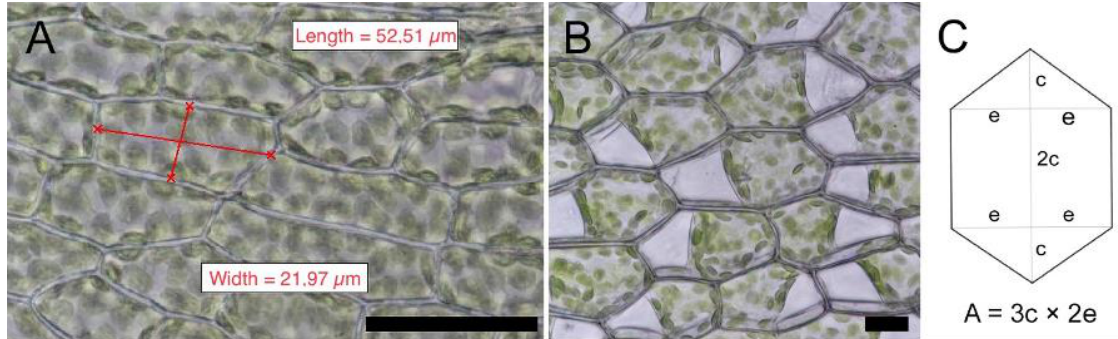
Figure 4. ( A ) measurements of cell length and widths in rectangular cells using the “extended focus” function (Nikon NIS - ElementsBR) of the microscope; bar: 50 µM; and ( B ) hexagonal cell type of P. affine , plasmolyzed in 0.8 M mannitol for 20 min; the protoplasts are detached from the cell wall; bar: 25 µM. ( C ) schematic and formula for area calculation of hexagonal cells (changed after Hnilica and Kohout 2018).